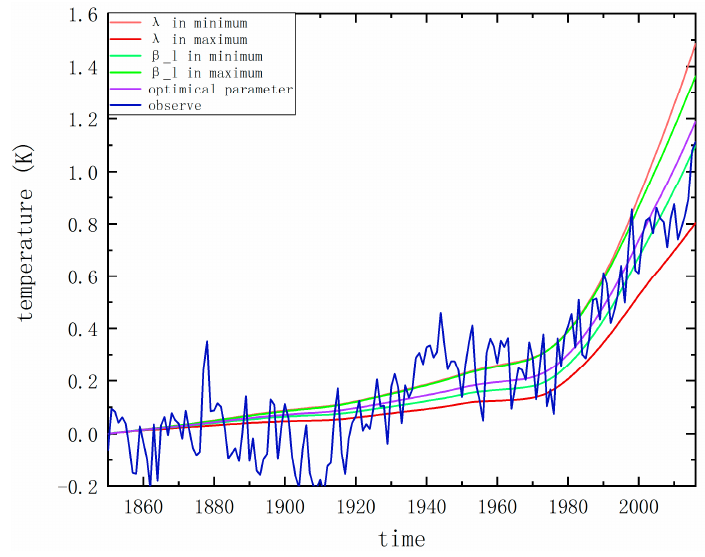
Figure 6. Sensitive parameters’ impact on model temperature output.